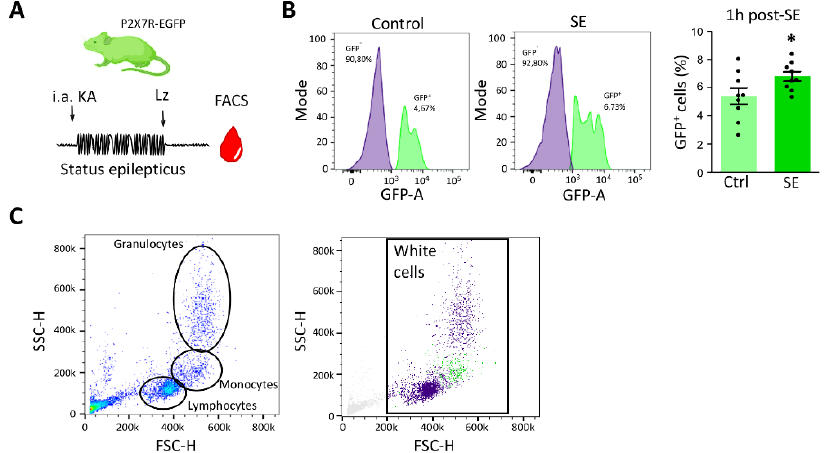
Figure 3. Increased P2X7R expression in blood cells post ‐ status epilepticus in mice. ( A ) Mice ex ‐ pressing P2X7 C ‐ terminally fused to EGFP are subjected to intra ‐ amygdala KA ‐ induced status epi ‐ lepticus. Blood was collected 1 h post ‐ treatment with the anticonvulsant lorazepam. ( B ) Graph showing the histogram of the GFP ‐ A (area) in control conditions and 1 h post ‐ SE. The percentage of GFP + cells is significantly increased in animals treated with intra ‐ amygdala KA 1 h post ‐ lorazepam (SE) when compared with vehicle ‐ injected control mice (Ctrl) (N = 9 per group) (Unpaired Student’s t ‐ test, p = 0.0493). ( C ) Forward side scatter indicating the distribution of the GFP + cell population (in green). Note, size and complexity suggests the GFP + cell population being composed mainly of mon ‐ ocytes. * p < 0.05. 3.4. Increased KC/GRO Plasma Levels in P2X7 − / − Mice Post ‐ Status Epilepticus The P2X7R is an important regulator of the release of cytokines in the brain and cir ‐ culation [20,45], suggesting changes in circulating cytokines could be potential readouts or surrogates of P2X7R activity/inhibition. Moreover, circulating cytokines have been pro ‐ posed as possible diagnostic tools for numerous brain diseases, including epilepsy [46]. To explore whether the P2X7R contributes to a specific cytokine signature following sei ‐ zures, we measured cytokine levels in brain tissue (hippocampus) and plasma under con ‐ trol conditions and 8 and 24 h following status epilepticus in wt mice and mice deficient in P2X7R ( P2X7 − / − ) using the V ‐ PLEX Plus Mouse Cytokine 19 ‐ Plex Kit (Figure 4A). This assay measures levels of nineteen different cytokines and chemokines (see Materials and Methods and Supplementary Tables S2 and S3). Both genotypes experienced similar seizures during status epilepticus (Figure 4B), in line with previous studies using the same transgenic P2X7 − / − mouse model [34]. This sug ‐ gests differences in cytokine profiles are not due to differences in seizure severity between genotypes. Cytokine profiles in wt mice changed in the hippocampus, as expected, fol ‐ lowing status epilepticus, including elevations in IL ‐ 1 β , TNF ‐α , and MCP ‐ 1 (Supplemen ‐ tary Tables S2 and S3 and Supplementary Figure S2A) [43,47]. Unexpectedly, levels of several cytokines were increased in mice lacking the P2X7R compared with wt after status epilepticus including both anti ‐ inflammatory cytokines (e.g., IL ‐ 10, IL ‐ 2, IL ‐ 4) and pro ‐ inflammatory cytokines (e.g., IL ‐ 6 and TNF ‐α ) and chemokines (e.g., MIP ‐ 1 α , MIP ‐ 2, KC/GRO) (Supplementary Tables S2 and S3). This indicates that the P2X7R may suppress as well as promote inflammatory signaling and that factors in addition to the P2X7R con ‐ tribute to the release of cytokines. Based on these findings, we selected cytokines to validate the array ‐ based screen in a separate cohort of mice via ELISA. This included the known P2X7R targets IL ‐ 1 β and IL ‐ 6 [45] and the cytokine KC/GRO which, although not previously described to be regu ‐ lated by the P2X7R, appeared to be differently regulated between genotypes in both the